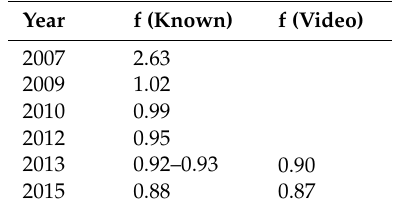
Table 3. Variations of the first lateral natural frequency f of the Kanellopoulos Bridge, known from the analysis of geodetic sensors and accelerometers (from Thalla and Stiros [11], with additions) and those derived in this